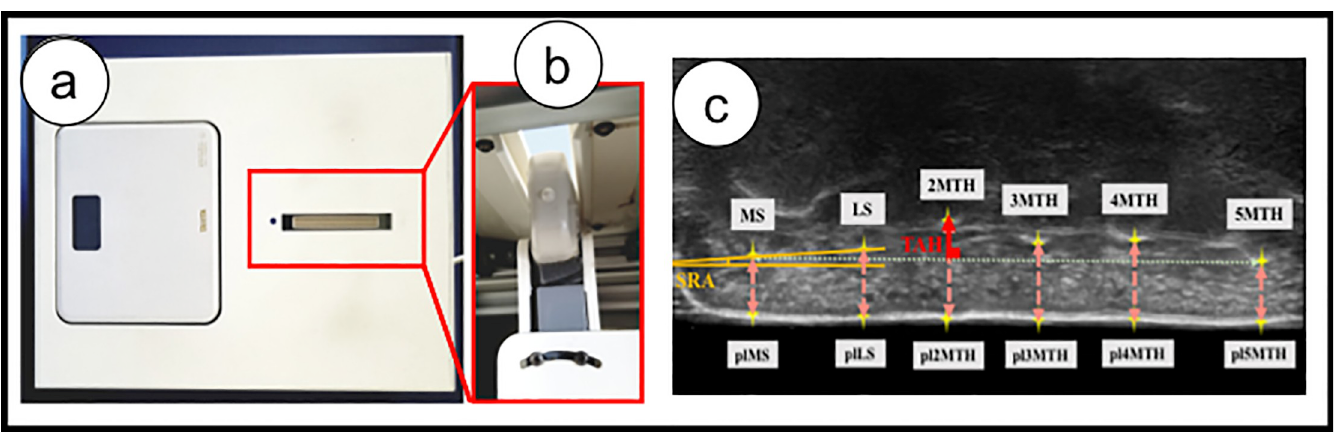
Fig 1. Weight-bearing plantar ultrasound imaging device and ultrasound images. (a) WPUID constructed with an internal probe allowing coronal views of the transverse arch; (b) ultrasound probe inserted upside-down and an upper opening for a gel pad to be placed on the probe; (c) shows the ultrasound image: the lowest point of the MS, LS, 2MTH, 3MTH, 4MTH and 5MTH as well as their plantar projections were marked by yellow stars. TAH (red line) is the distance from 2MTH perpendicular to the line passing through MS and 5MTH. Metatarsal heads’ height (orange dotted lines) is the distance between the lowest point of the bone and its plantar surface marker. SRA (yellow angle) is the angle between the line passing through MS and LS and the line passing through MS and 5MTH. US: ultrasound; WPUID: Weightbearing Plantar Ultrasound Imaging Device; MTH: metatarsal head; TAH: transverse arch height; SRA: sesamoid rotation angle; MS: medial sesamoid; LS lateral sesamoid; 2MTH: second metatarsal head; 3MTH: third metatarsal head; 4MTH: forth metatarsal head; 5MTH: fifth metatarsal head; pl: plantar